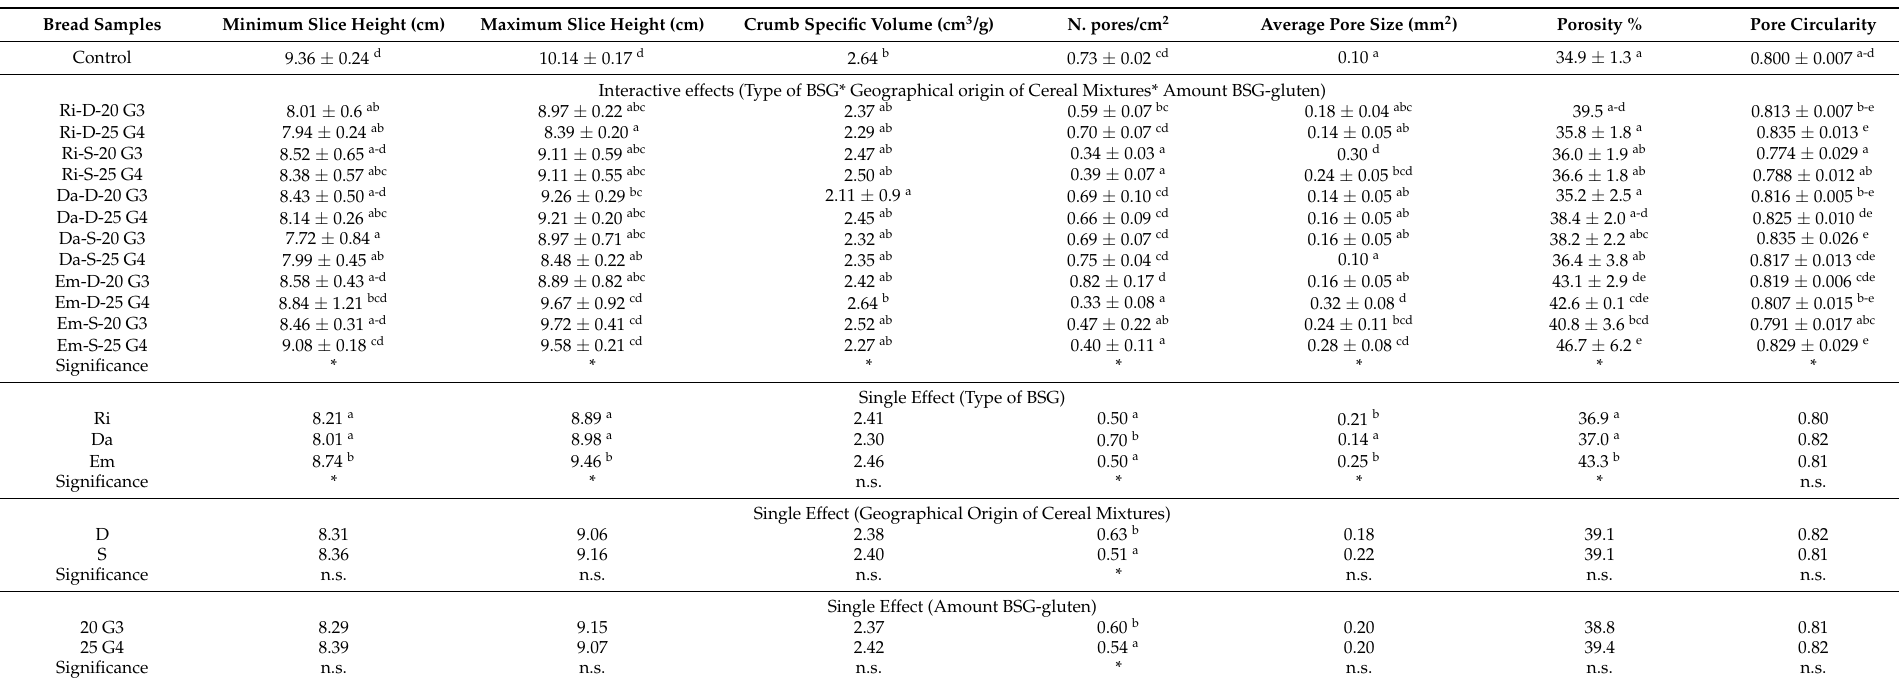
Table 7. Effects of type of BSG, geographical origin, and amounts of BSG-gluten in the formulation on structural characteristics of the functional breads. Bread